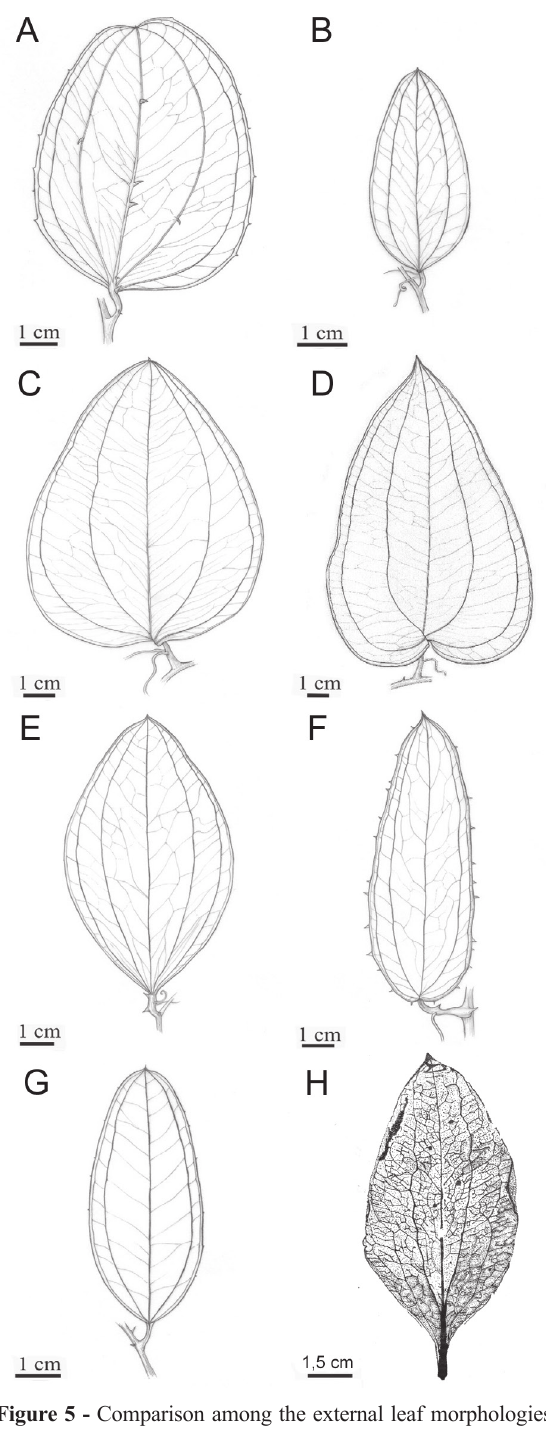
Figure 5 - Comparison among the external leaf morphologies of Cratosmilax jacksoni gen. et sp. nov and seven species of Smilax . A. Smilax brasiliensis . B. Smilax campestris . C. Smilax cissoids . D. Smilax fluminensis . E. Smilax goyazana . F. Smilax oblongifolia. G. Smilax rufescens . H. Cratosmilax jacksoni . From A to G after Martins et al.